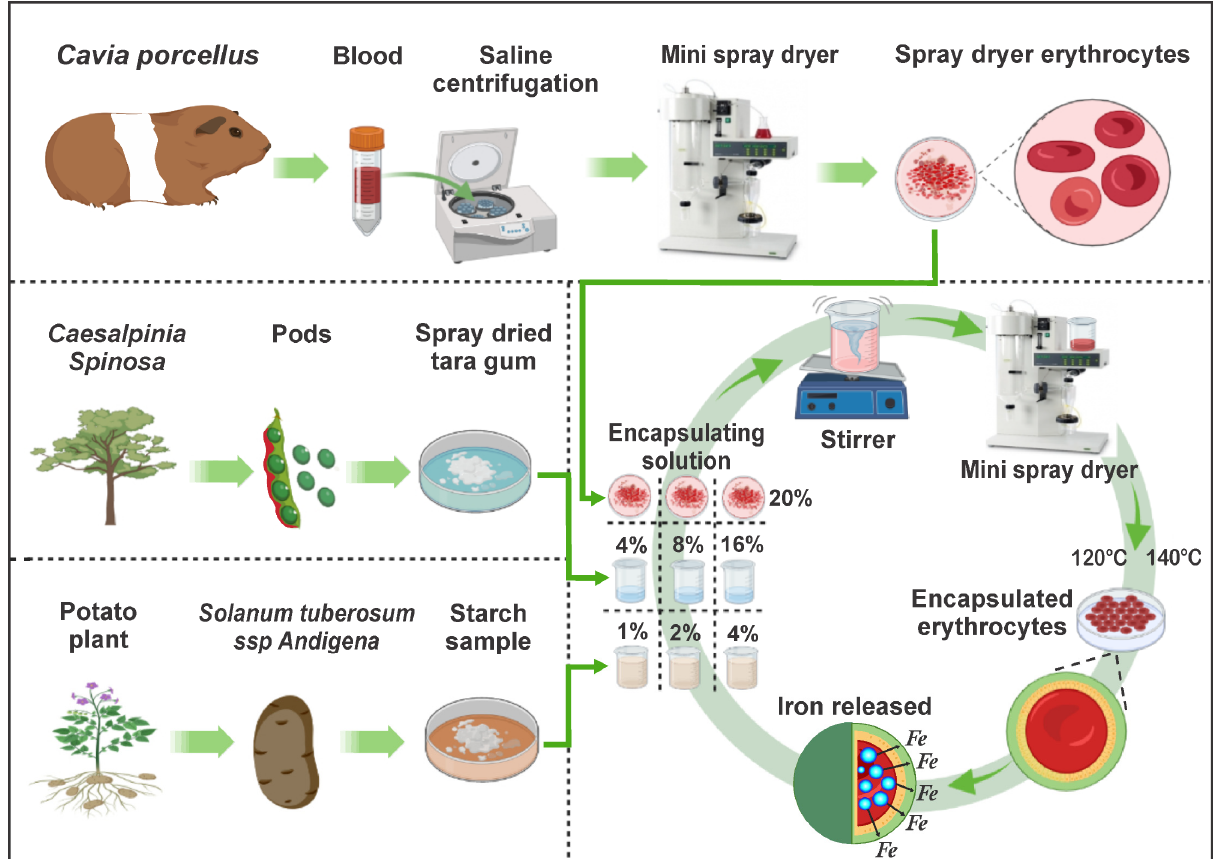
Figure 1. Experimental flow diagram.